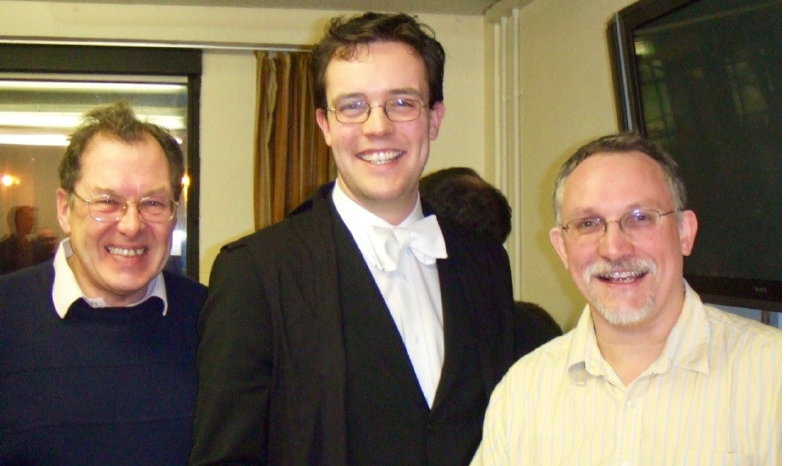
Figure 2. Bob Sim with Simon Clark and Tony Day. Taken after Simon’s DPhil viva in 2006. Tony